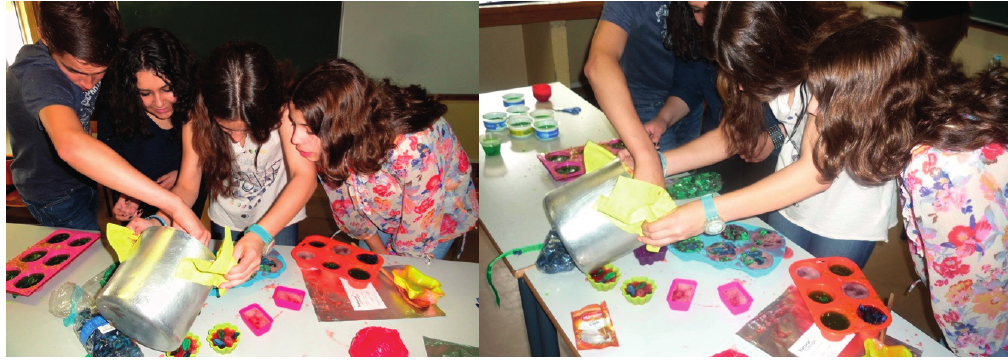
Figure 2. Preparation of soaps containing plant extracts by the